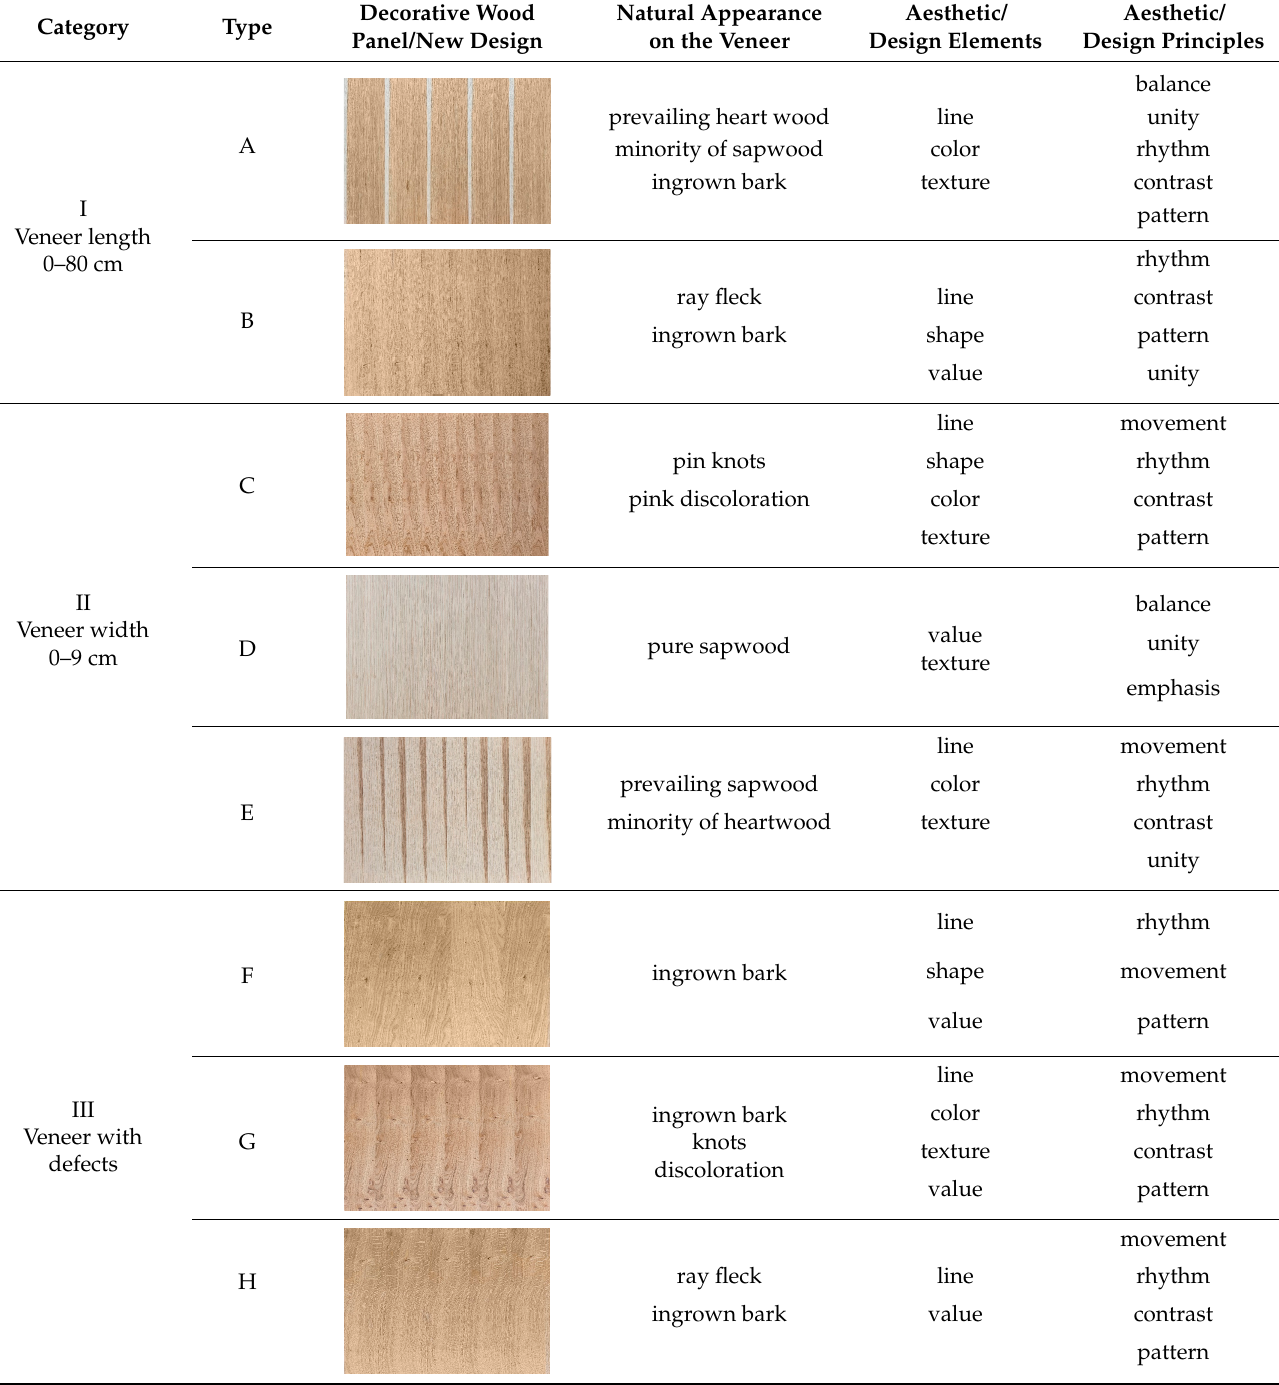
Table 1. Samples of designed decorative panels from residue veneer: (A) heartwood/sapwood; (B) ray fleck/ingrown bark; (C) pin knots/discoloration; (D) sapwood; (E) sapwood/heartwood; (F) ingrown bark; (G) ingrown bark/knots/discoloration; (H) ray fleck/ingrown bark; and associated design elements and principles. (© Domagoj Mami´c,